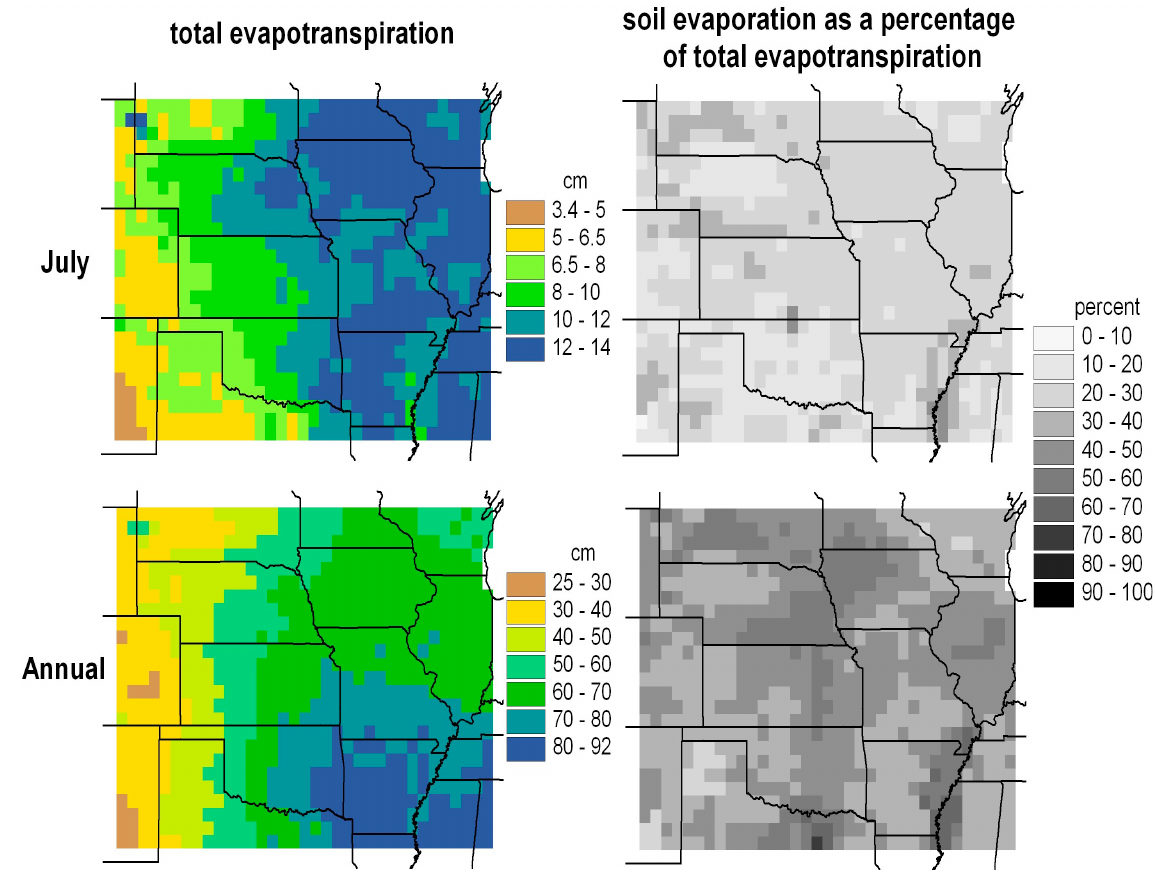
Fig. 11. Average total evapotranspiration and soil evaporation as a percentage of total evapotranspiration for July and the entire year